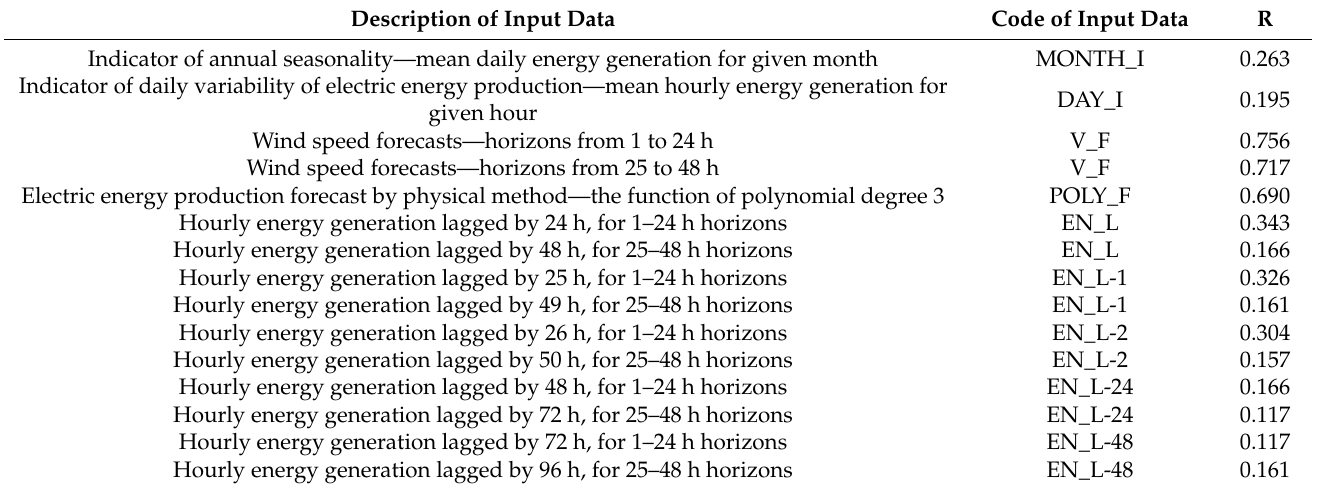
Table 3. Pearson linear correlation coefficients between selected input variables and energy